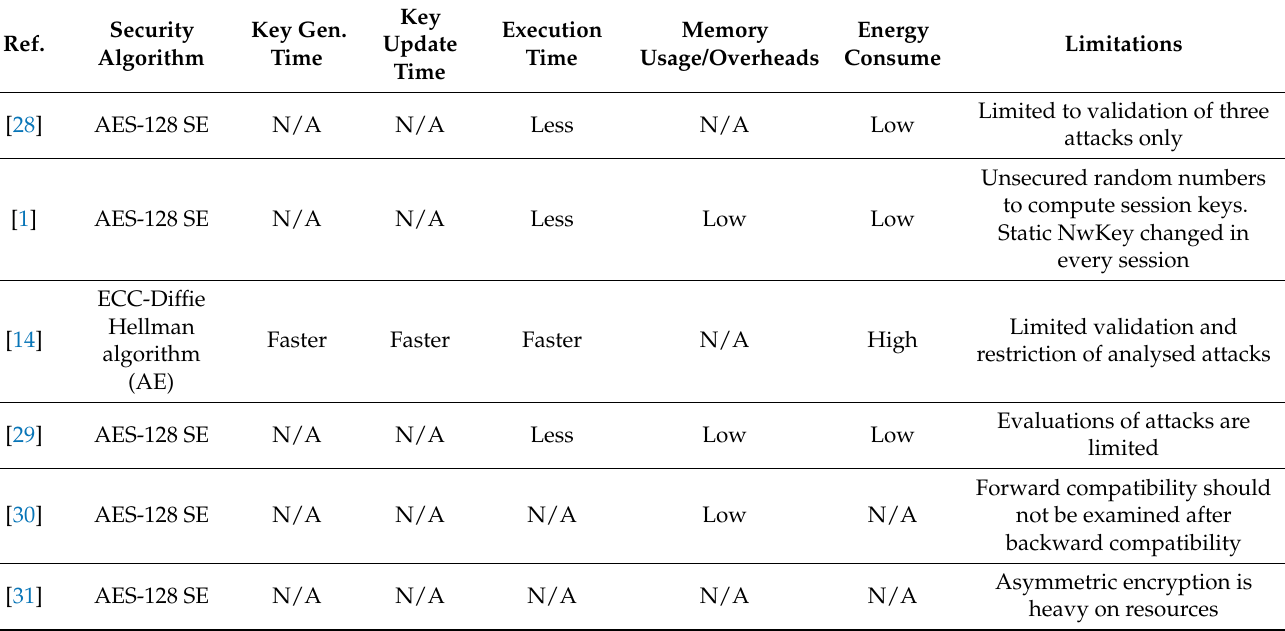
Table 3. Summary of Security Algorithms and Analysis in